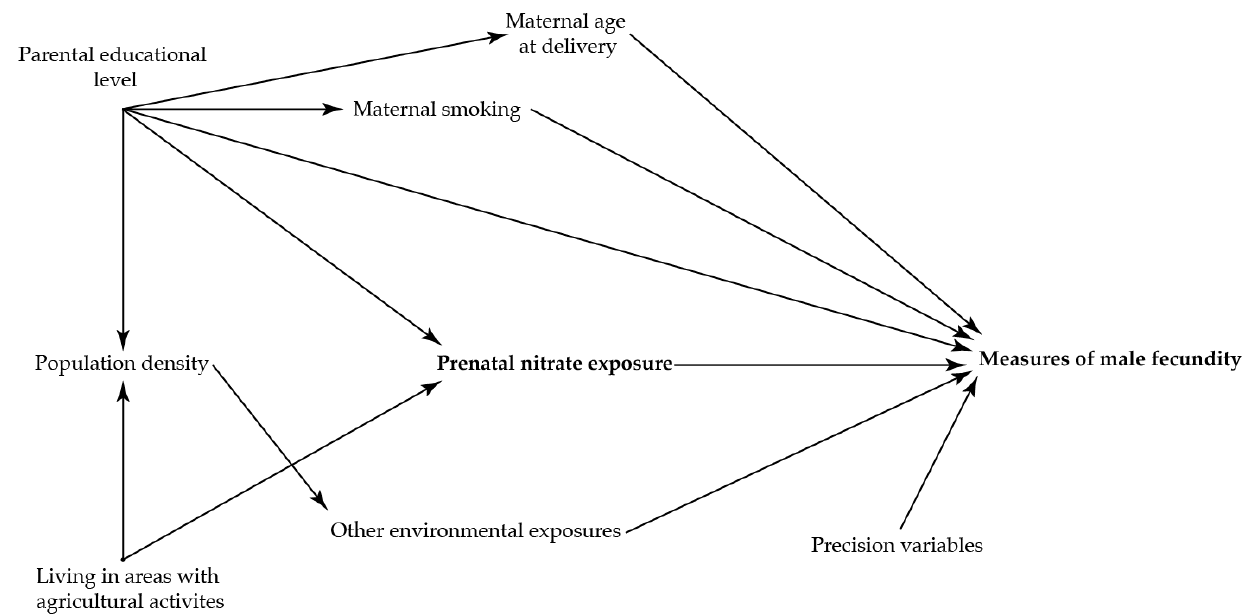
Figure 2. Directed acyclic graph illustrating the suggested associations between nitrate concentration in maternal drinking water and the reproductive health in the adult sons.